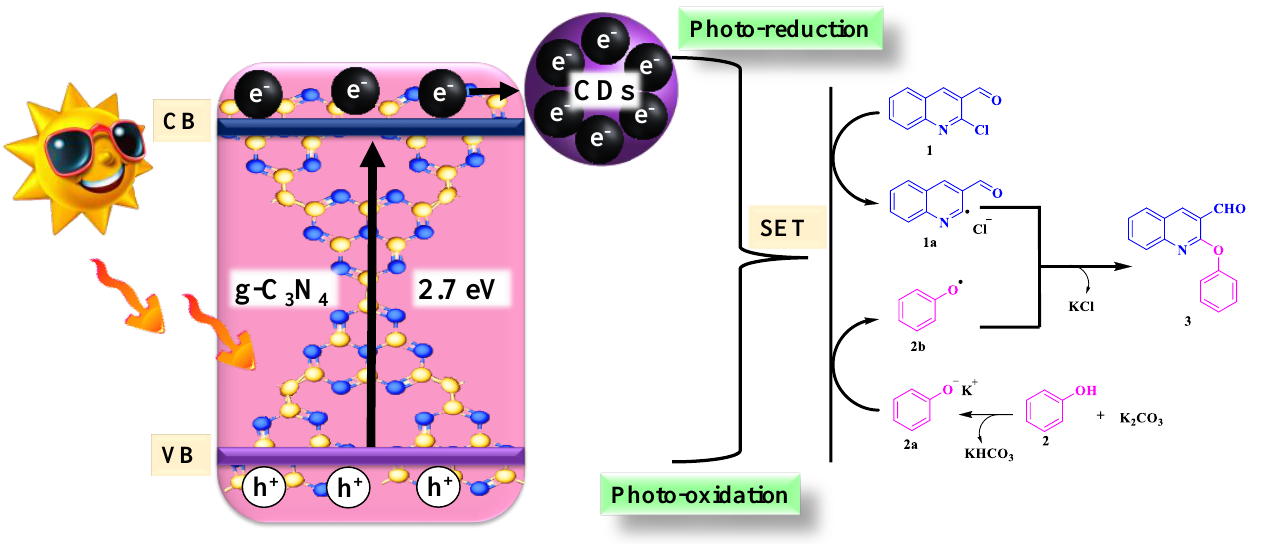
Figure 6. The charge transfer mechanism of the CDCN nanocomposite and a plausible mechanism.